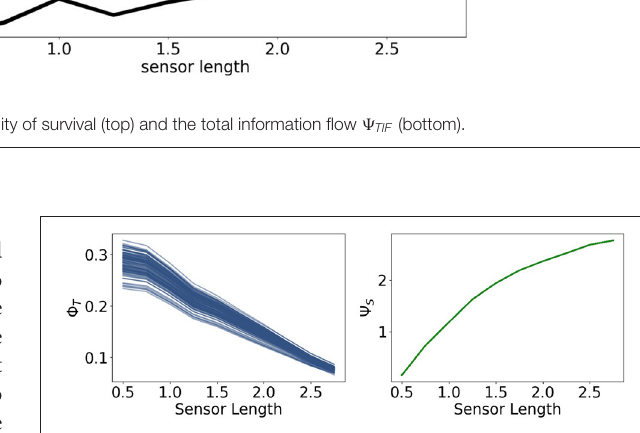
FIGURE 8 | Integrated information 8 T and morphological computation 9 S for the fully coupled